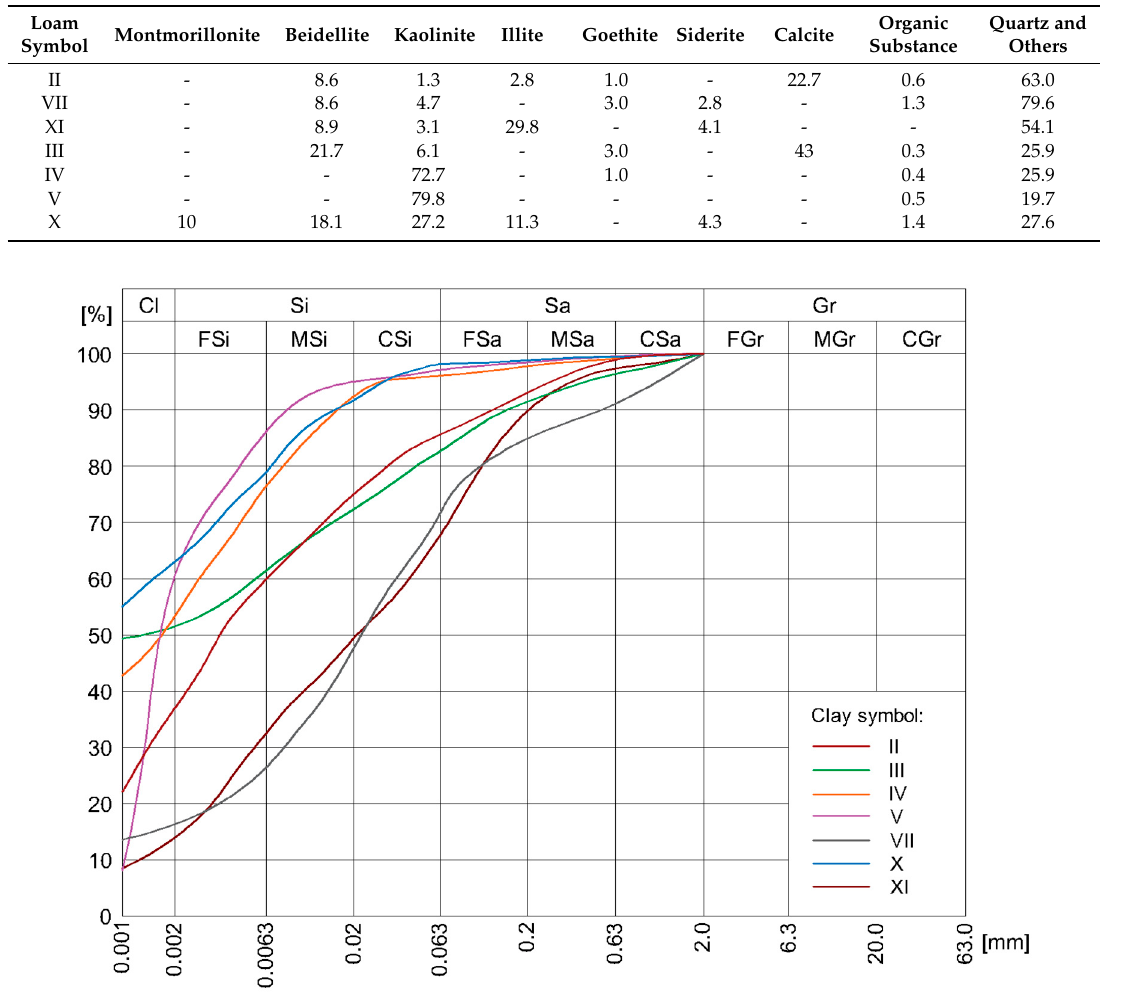
Figure 4. Granulation curves of selected clays.